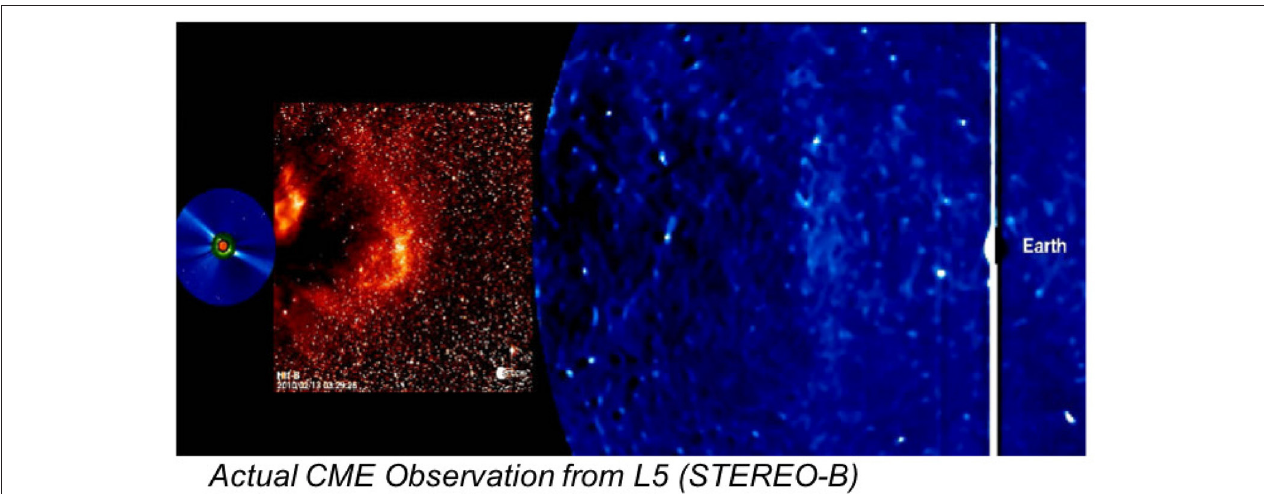
FIGURE 4 | Snapshot of an Earth-directed CME from the STEREO-Behind imagers while crossing the L5 point (02/13/2010 3:29 UT). The figure is a composite of the fields of view (FOVs) of all SECCHI imagers. The CME is in the HI1-B FOV at this time. The Earth is bright and saturates a few columns in the HI2-B FOV. The faint broad front of a preceding CME can be discerned in HI2-B.